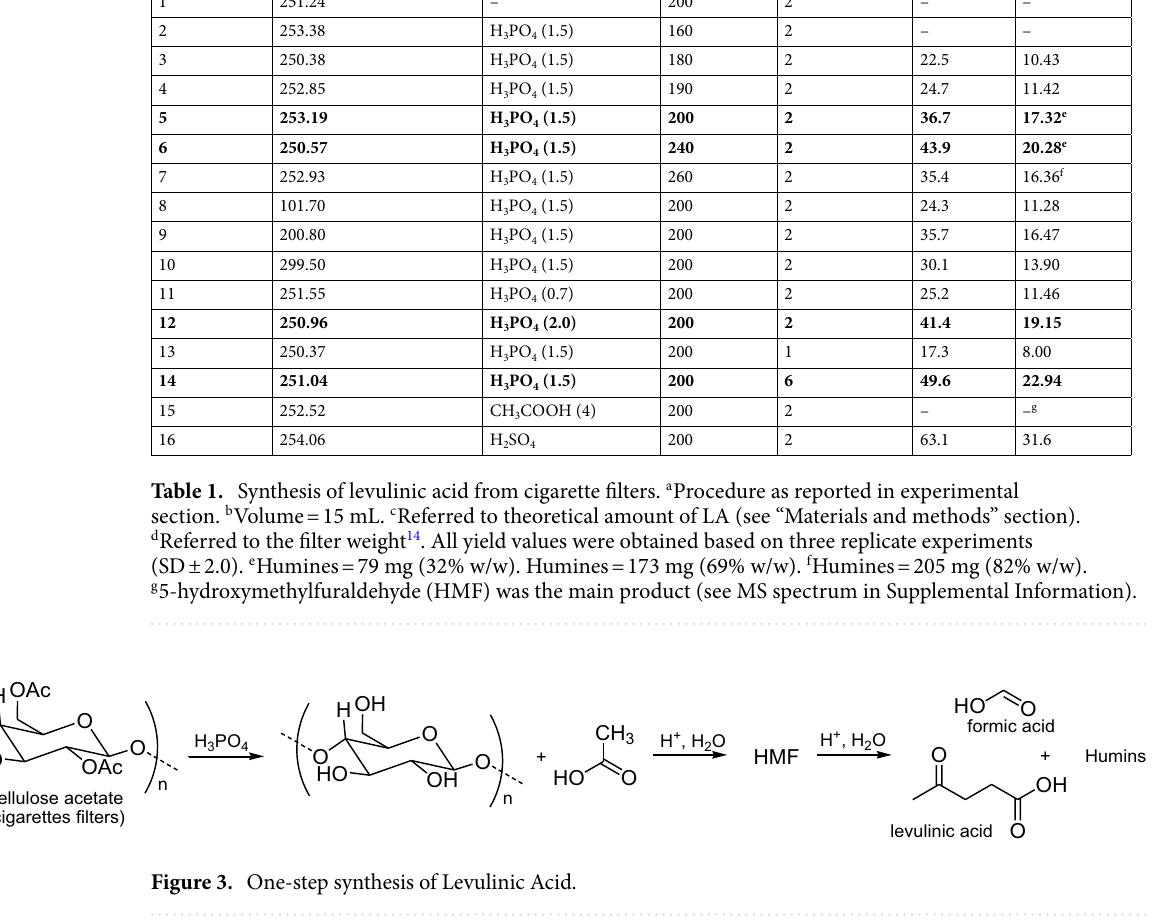
(Table 1). Formation of Levulinic Acid was surveyed by GC/MS and NMR techniques. Both unsmoked and smoked cigarette butts were tested as source of cellulose biomass, whereas acetic and formic acids were formed as by-products together with HMF as an intermediate (Fig. 3) 16,26 .